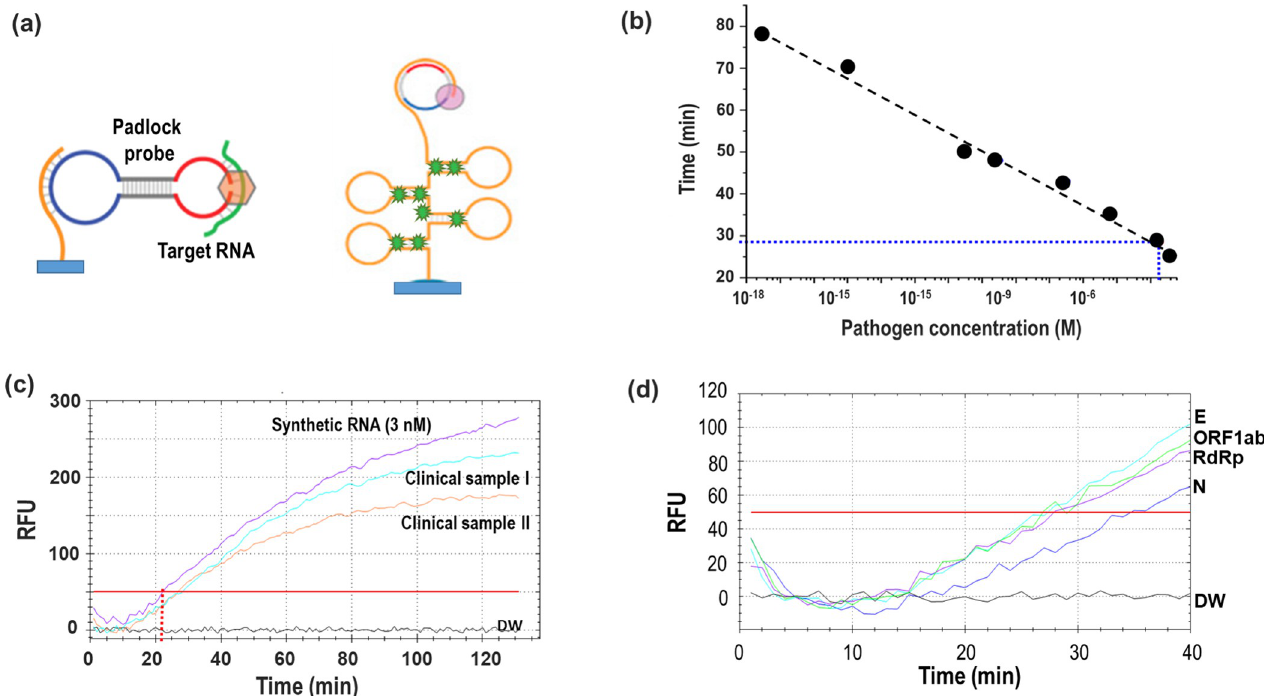
Fig 3. (A) Schematic of RCA using padlock probe; (B) calibration curve for detecting synthesized SAR-CoV-2 RNA with decreasing concentration; (C) comparison of RCA-FL results between synthetic RNA (3 nM) and clinical mask samples; (D) RCA-FLPCR results for four target pathogens from a clinical mask